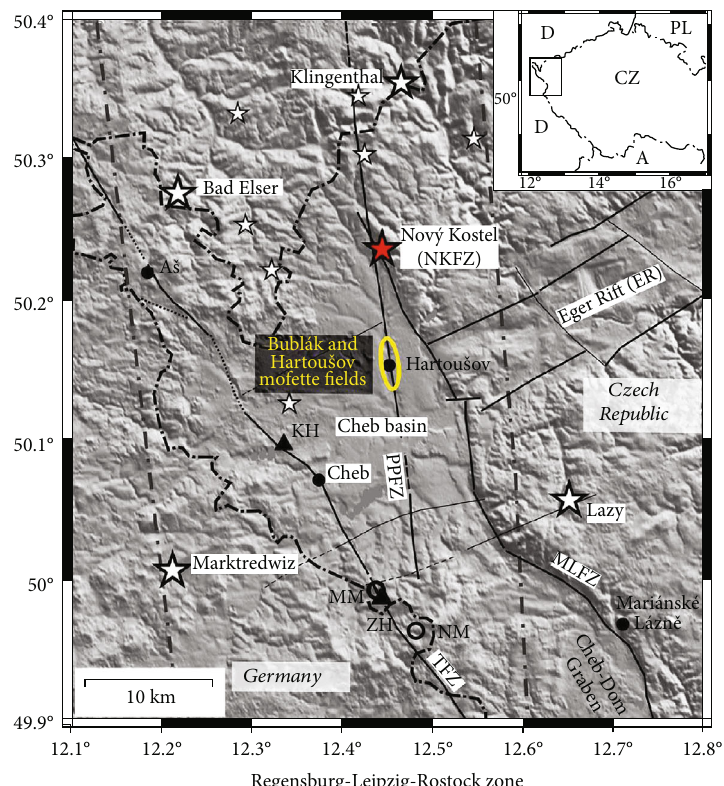
Figure 1: Fault zones in the Cheb Basin with Pleistocene scoria cones Ž elezná h ů rka (ZH) and Komorní h ů rka (KH) (black triangles); black circles mark Mýtina maar (MM) and Neualbenreuth maar (NM); PPFZ Po č átky Plesná fault zone, MLFZ Mariánské Lázn ě fault zone, TFZ Tachov fault zone; white stars point to further locations of swarm earthquake epicentral areas; the red star marks the NKFZ Nový Kostel focal zone [13, 28,